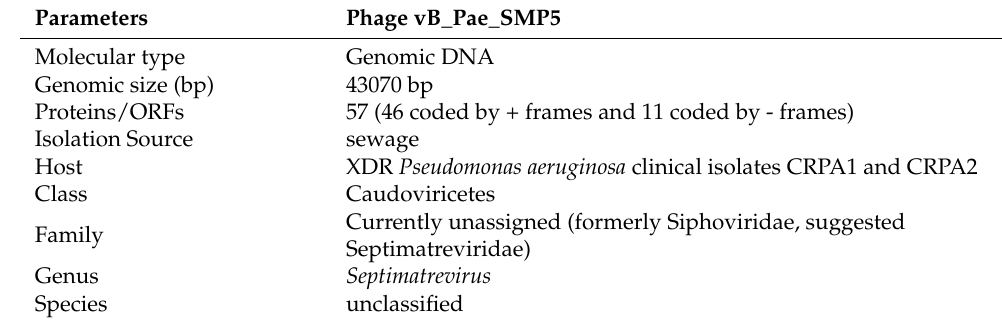
Table 3. Genomic and phenotypic characterization of the phage vB_Pae_SMP5.